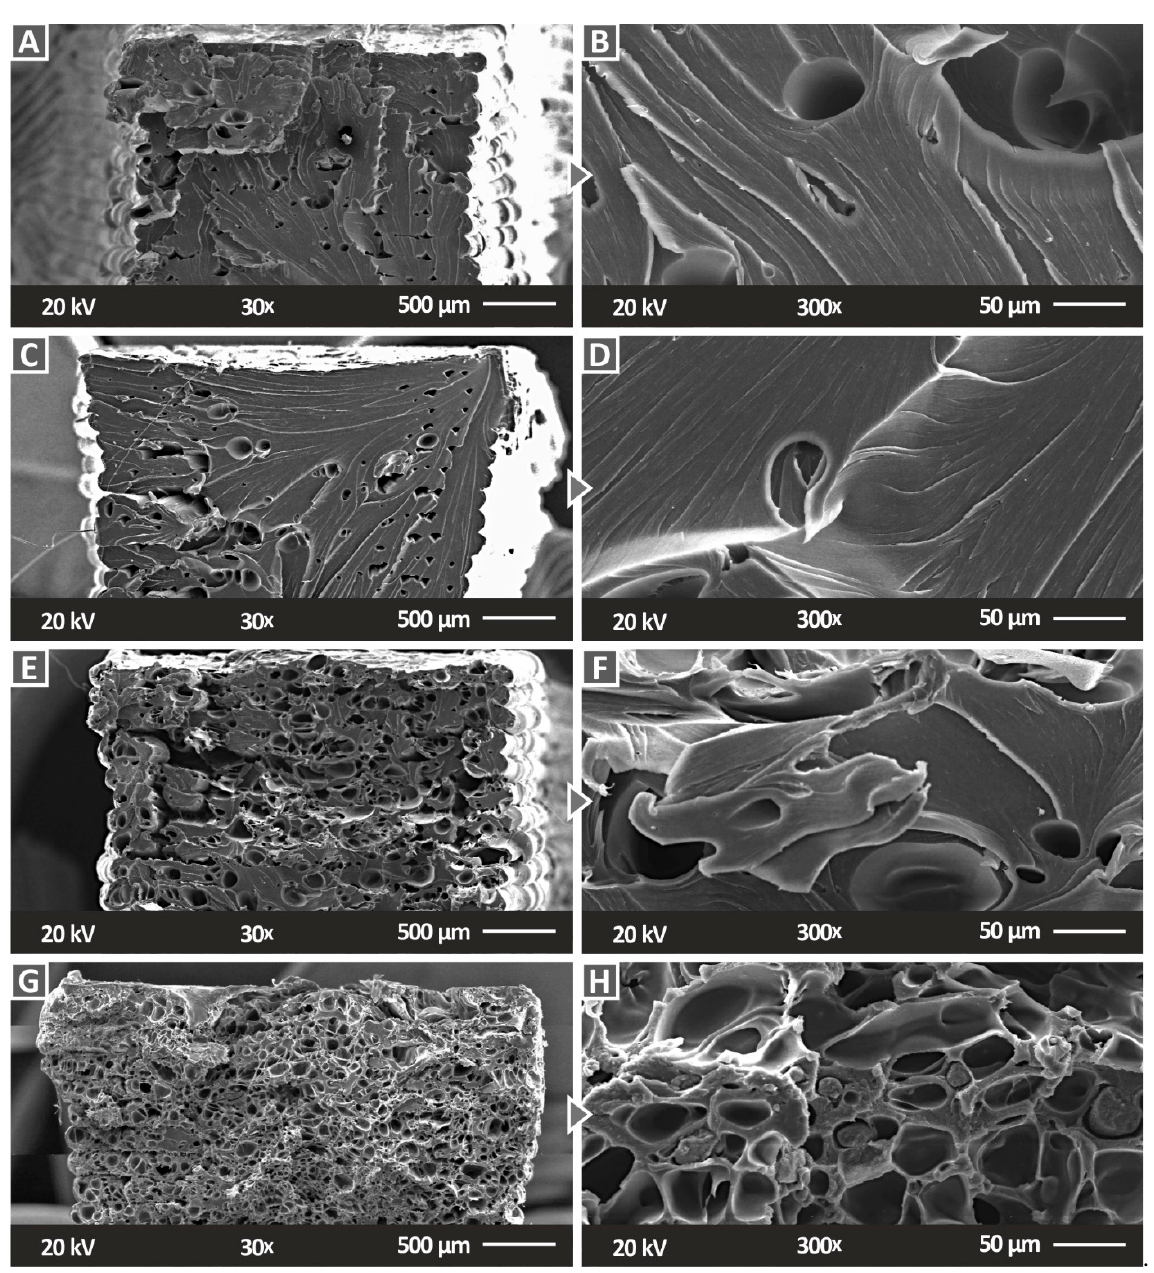
Figure 11. SEM micrographs of the fracture surface of the prepared PC/SiC nanocomposites: ( A ) 30× magnification, 1 wt.%, ( B ) 300× magnification, 1 wt.%, ( C ) 30× magnification, 2 wt.%, ( D ) 300× magnification, 2 wt.%, ( E ) 30× magnification, 3 wt.%, ( F ) 300× magnification, 3 wt.%, ( G ) 30× magnification, 6 wt.%, and ( H ) 300× magnification, 6 wt.%.